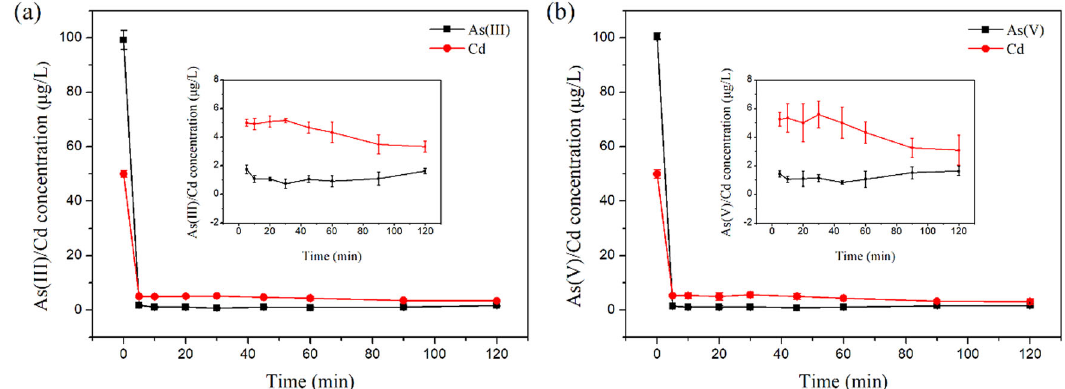
Fig. 1 In fl uence of reaction time on As and Cd concentrations in tap water treated by K 2 TiO(C 2 O 4 ) 2 and CaCl 2 . ( a ) 100 μ g/L As(III) and 50 μ g/L Cd co-contaminated tap water, ( b ) 100 μ g/L As(V) and 50 μ g/L Cd co-contaminated tap water. Other conditions were 40 mg/L K 2 TiO(C 2 O 4 ) 2 (or 5.7 mg-Ti/L), 55.5 mg/L CaCl 2 , initial pH of 7, and reaction took place at 20 ± 1 °C. Here error bars mean standard